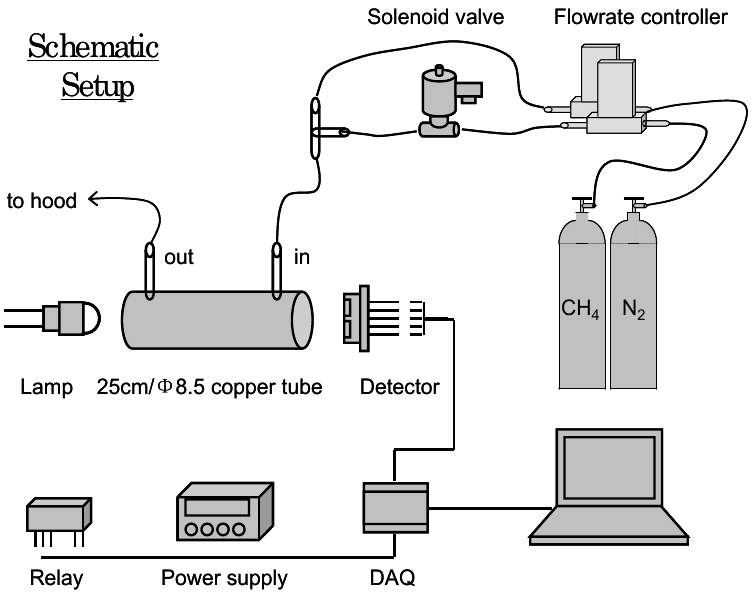
Figure 3. Schematic setup of the sensor prototype testing